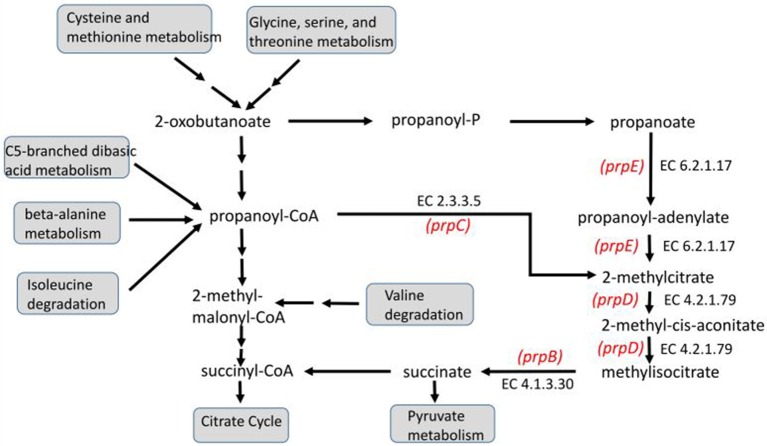
Propanoate metabolism and methylcitrate cycle mapping the sub-set of four enzymes codified by the genes dysregulated in the microarray data corresponding to the glucose-limited chemostat culture with the wild-type E. coli strain (first row, Experiment A, Table 2). The enzymes are indicated by their Enzyme Commission (EC) number, while the names of the genes that encode them are indicated in red. The diagram is a simplified adaptation based on KEGG Pathways (map 00640) after Ontology DAVID 6.8 software processing (FDR = 1 × 10−5).